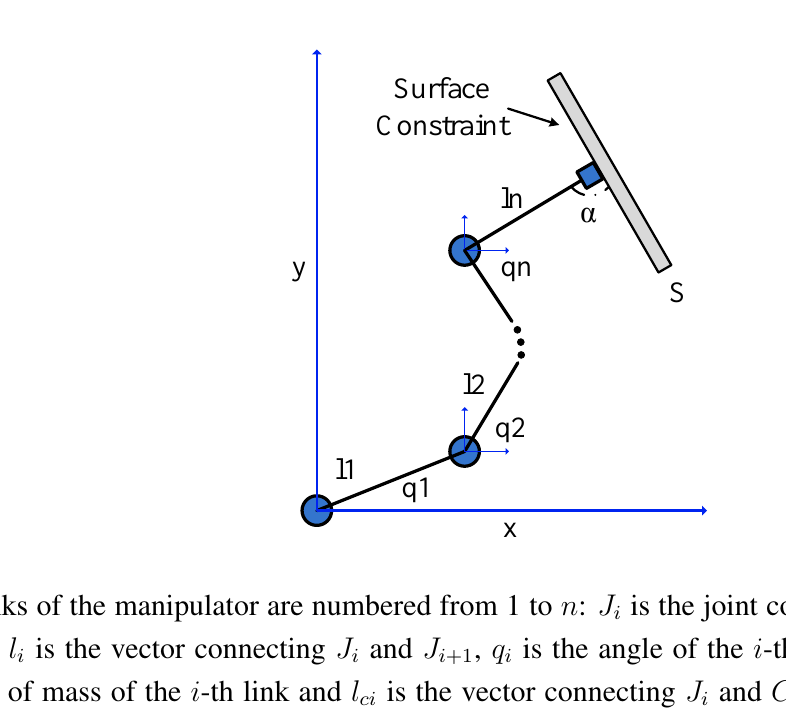
Figure 2. Constrained robot